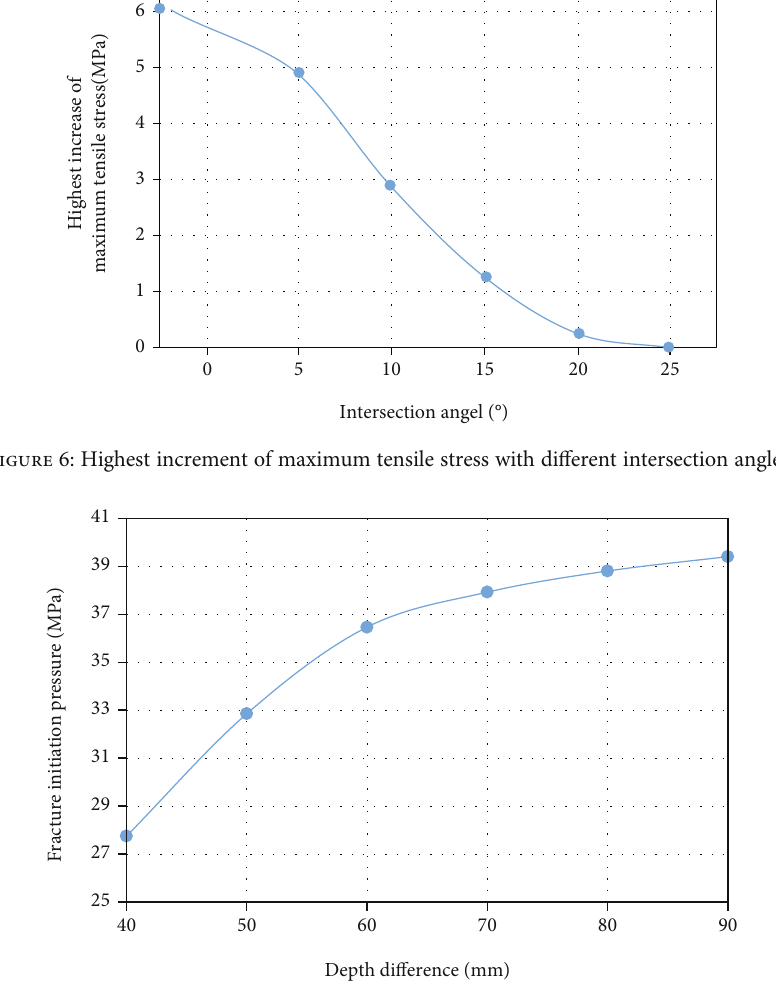
Figure 7: FIP with di ff erent depth di ff erences of radial